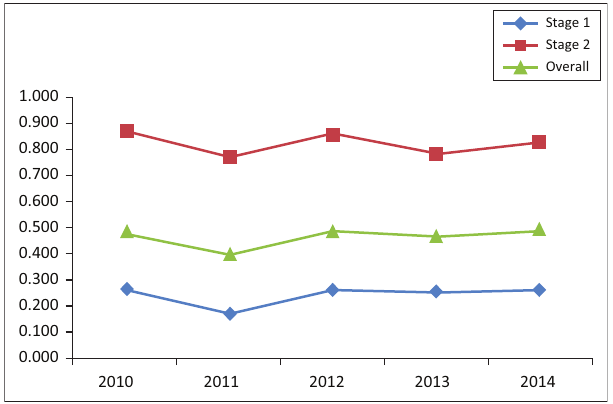
FIGURE 2: Average slack-based efficiency of two-stage model across the study period. TABLE 5: Results of Wilcoxon signed-rank test. Variable